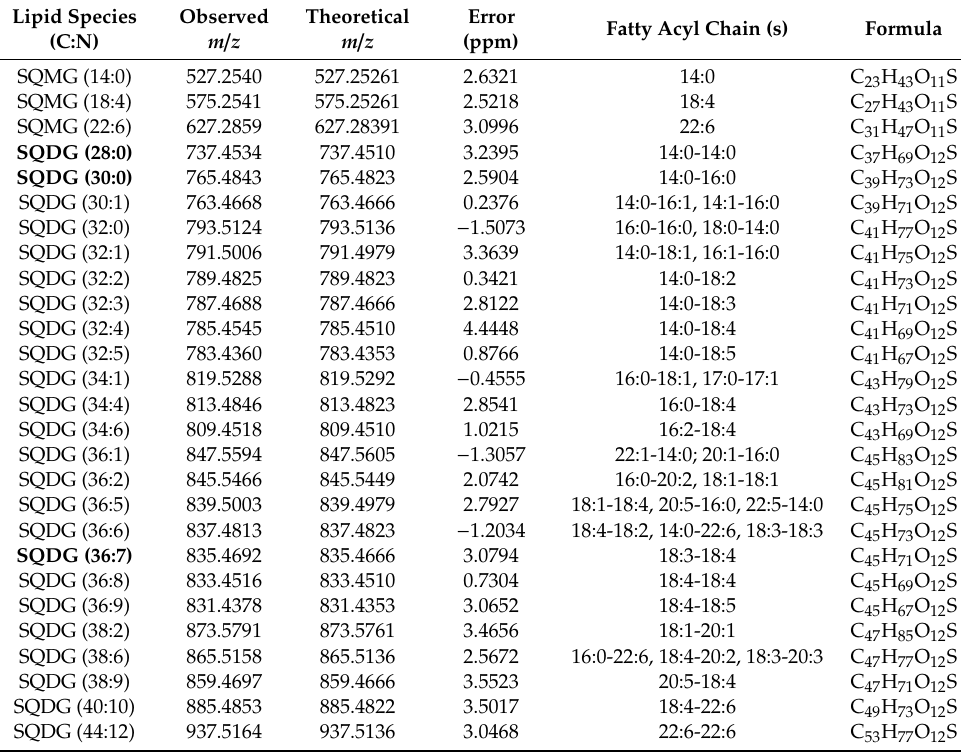
Table 2. Sulfolipid species identified by liquid chromatography–mass spectrometry (LC–MS) in negative mode as [M-H] − ions (error < 5 ppm). The identification as a sulfolipid and fatty acyl composition was confirmed by analysis of the tandem MS (LC–MS / MS) spectra of [M–H] – ions. The numbers in parentheses (C:N) indicate the total number of carbon atoms (C) and double bonds (N) in fatty acyl chains. The most abundant species of each class (relative abundance > 10 %) are indicated in